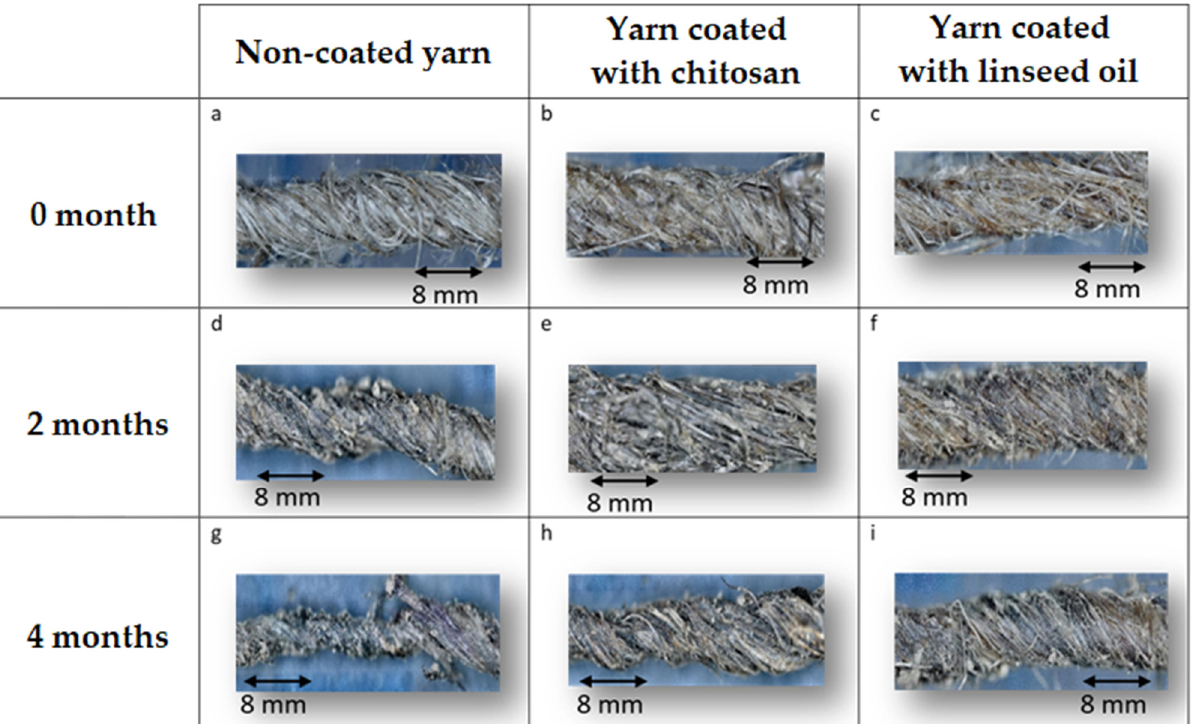
Figure 6. Microscopic representation of non-coated yarns after 0 ( a ), 2 ( d ) and 4 ( g ) months in the soil, yarns coated with chitosan after 0 ( b ), 2 ( e ) and 4 ( h ) months in the soil, and yarns coated with linseed oil after 0 ( c ), 2 ( f ) and 4 ( i ) months in the soil.